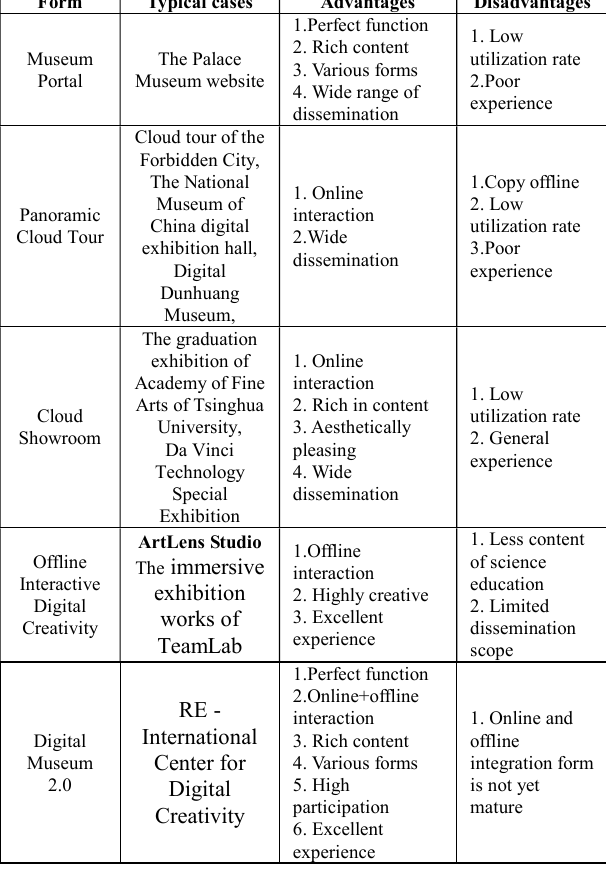
Table 1. Analysis of new forms of various digital